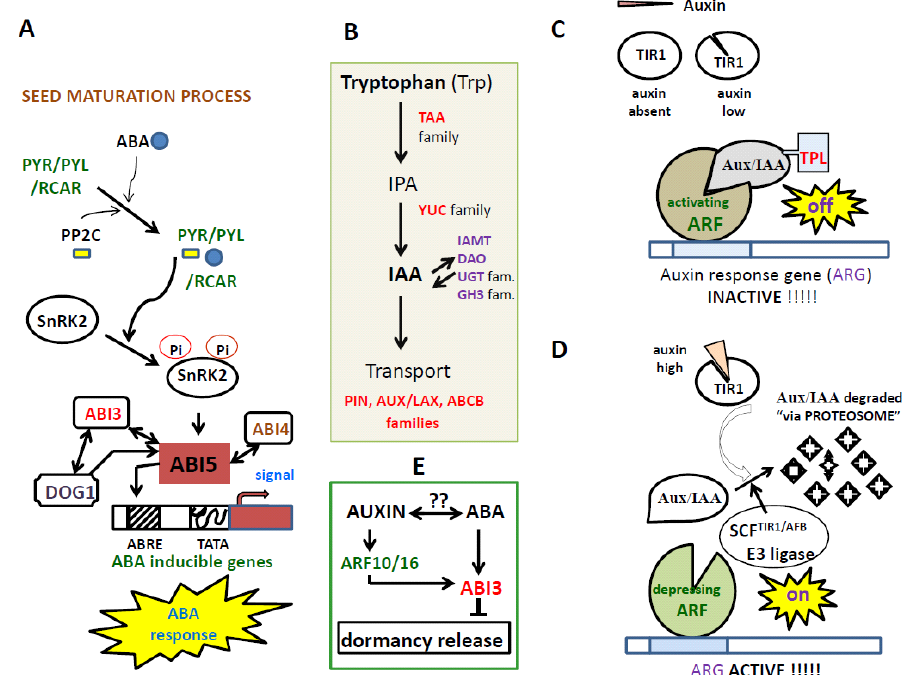
Figure 1. ( A ) In the presence of ABA, the ABA receptors PYR/PYL/RCAR form a complex with PP2C, and this inhibits the phosphatase activity of PP2C and thereby activate SnRK2. The activated SnRK2 subsequently turns on ABRE-binding protein/ABRE-binding factor (AREB/ABF) transcription factors (TFs), which in turn activates the transcription of ABA-responsive genes. Among AREB/ABF TFs, ABA insensitive 5 (ABI5), a member of the basic leucine zipper transcription factor family, plays a central role in regulating ABA-responsive genes in seeds. ABI4 and ABI3, AP2-type and B3-type TFs, respectively, have been reported to function together ABI5 to induce the expression of ABA-responsive genes, and thereby regulate seed dormancy and germination. ( B ) Auxin synthesis and transport involving TAA and YUC enzymes, and PIN, AUX/LAX and ABCB proteins. ( C ) When auxin levels are low, AUX/IAAs prevent ARF regulatory action on auxin-responsive genes. ( D ) If the cellular auxin level is high, auxin promotes interaction between TIR1/AFB and Aux/IAA proteins, resulting in degradation of the Aux/IAAs and the release of ARF repression. ( E ) Hypothesis of interaction between auxin-ABA to inhibit the primary seed dormancy release with ABI3 as a trigger.